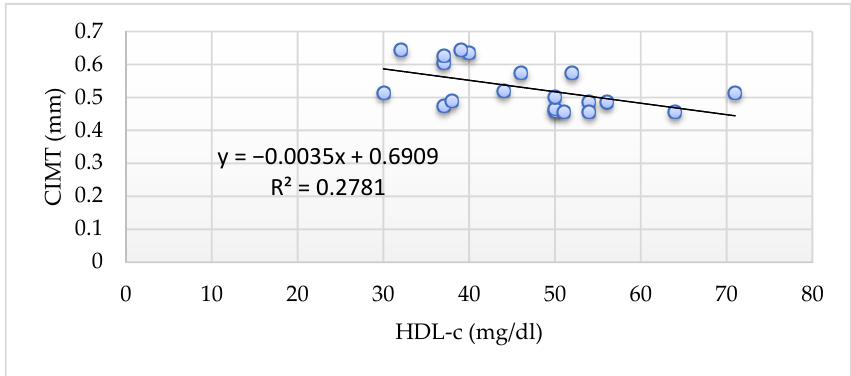
Figure 7. Correlation between CIMT and HDL-c in obese children.